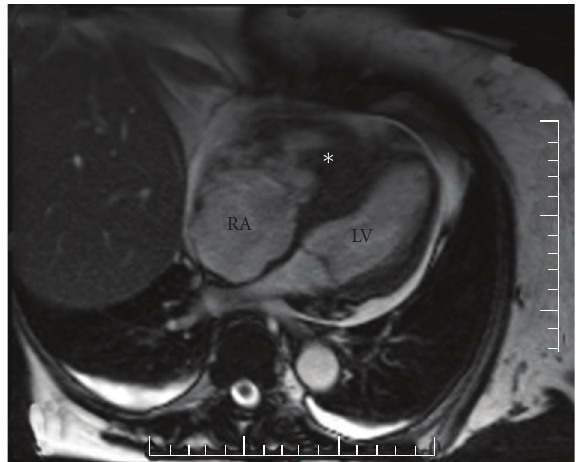
Figure 1: A magnetic resonance image (with gadolinium) shows a transverse view of the heart in diastole. The mass in the right ventricle ( asterisk ) fills most of the ventricle, and impedes filling of the left ventricle (LV). Note also the severe dilatation of the right atrium (RA) as well as the pericardial e ff usion